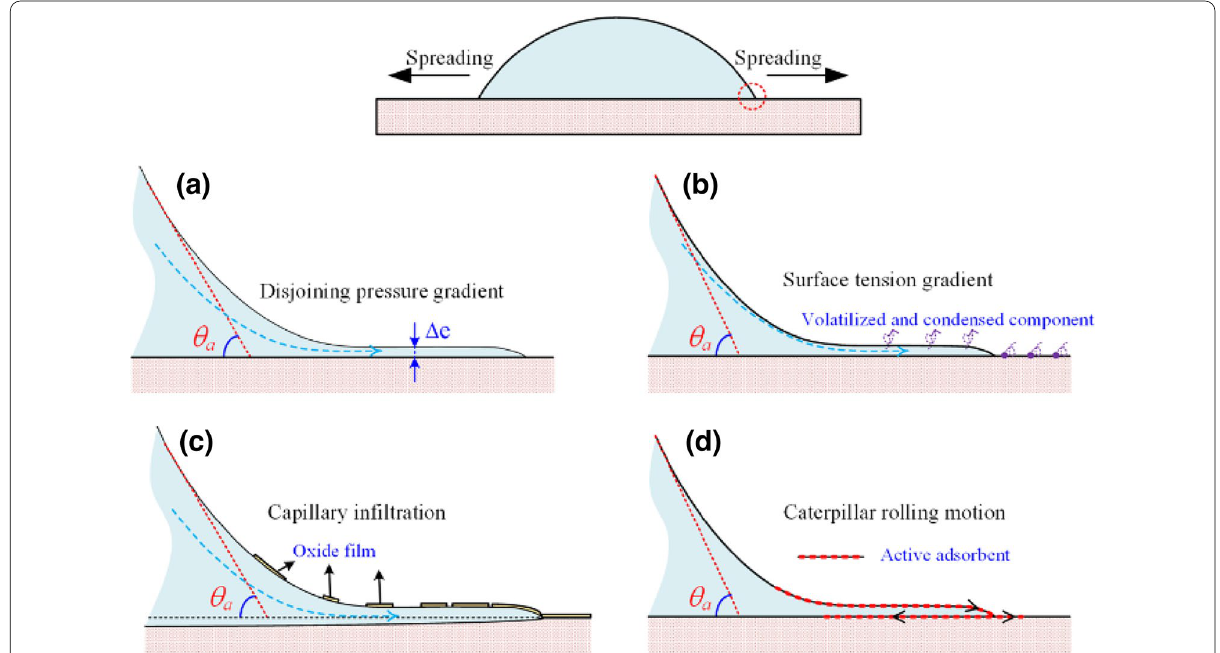
Figure 1 Schematics for ( a ) surface diffusion mechanism, ( b ) evaporation-condensation mechanism, ( c ) subcutaneous infiltration mechanism, and ( d ) rapid absorption and film overflow mechanism